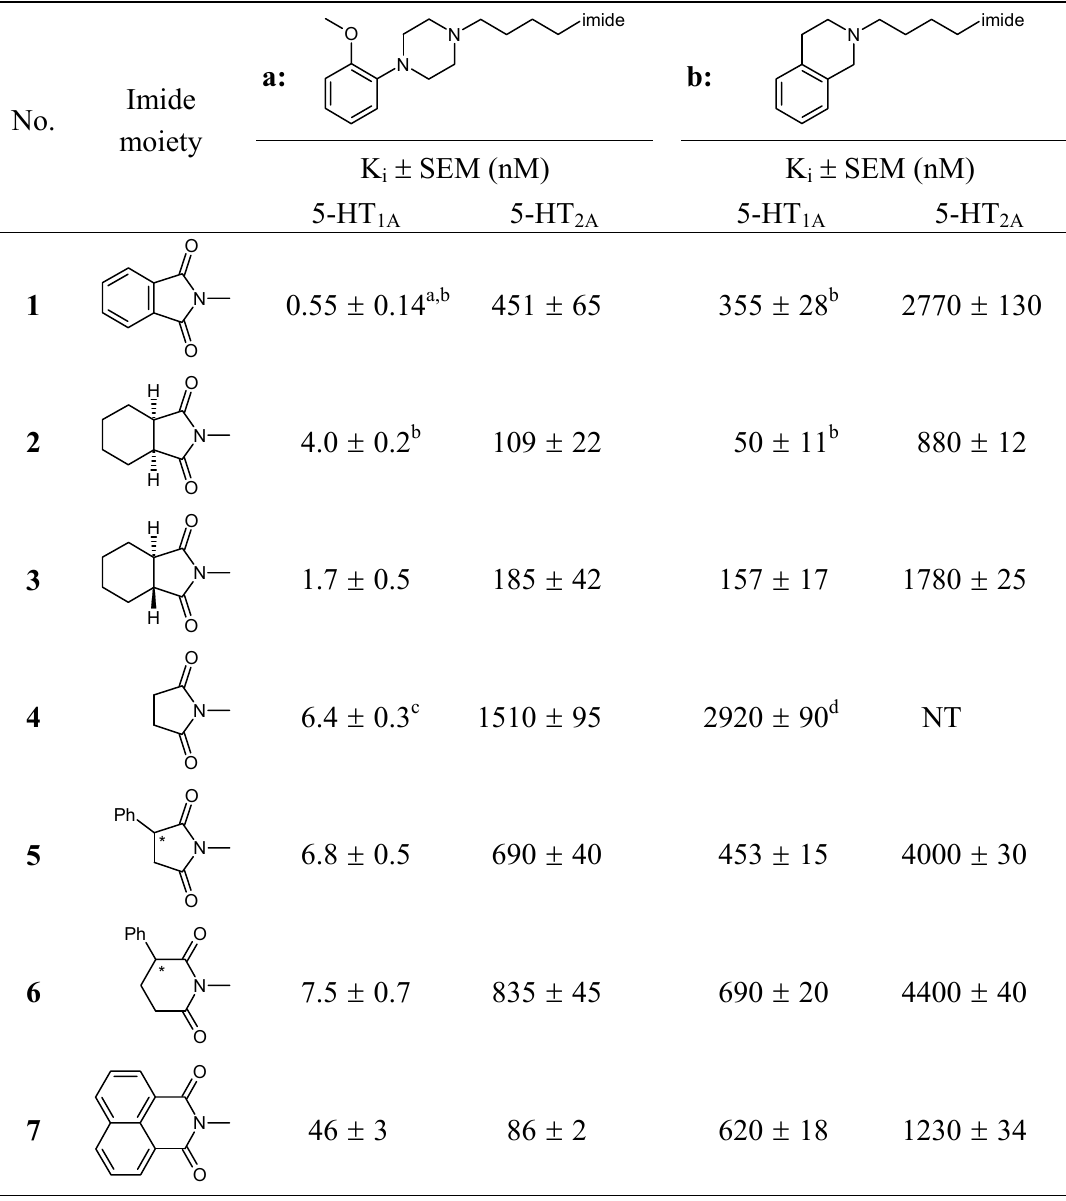
Table 1 . Structure and 5-HT Imide No. moiety